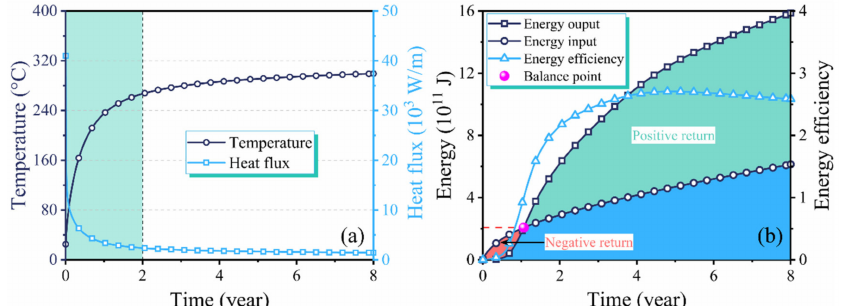
Figure 4. Temperature and energy evolution during the in situ conversion process: ( a ) evolution of average reservoir temperature and heat flux of heating wells; ( b ) evolution of energy input, energy output, and energy efficiency.